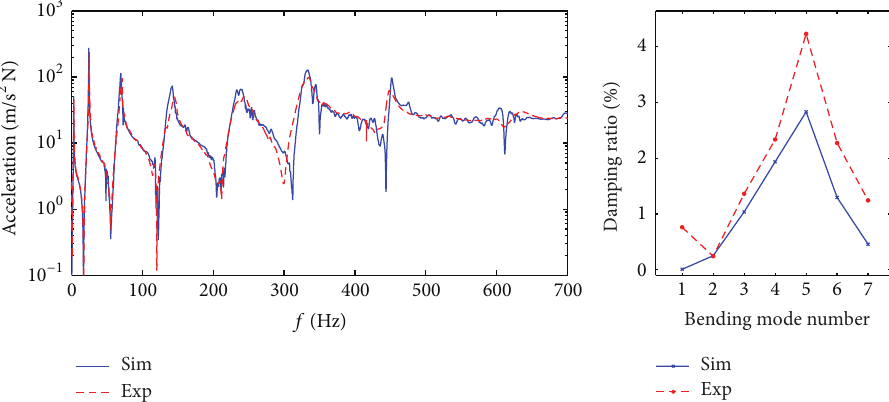
Figure 5: Measured and simulated FRFs for impulse excitation and 𝐹 𝑁,1 = 100 N, 𝐹 𝑁,2 = 6000 N (excitation and measurement close to tip on the mid-axis) and determined modal damping